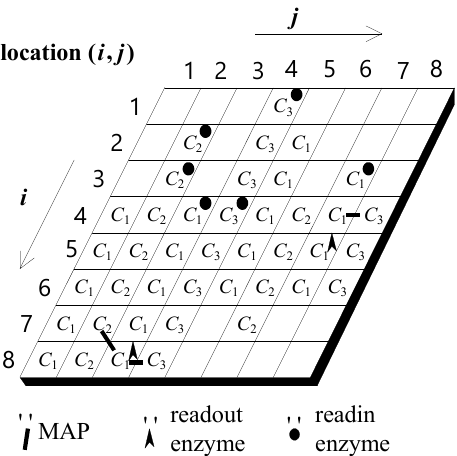
Figure 2. Conceptual architecture of an IP neuron.